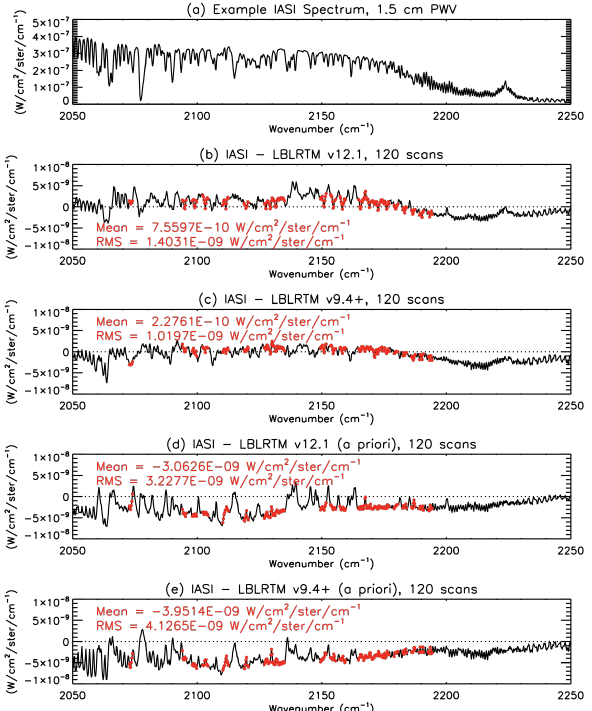
Fig. 27. (a) IASI-observed radiance spectrum in the fundamental vi- brational band of CO for an example profile with 1.5cm PWV. (b) Mean of the final (a posteriori) radiance residuals for 120 spectra us- ing LBLRTM v12.1. (c) Mean of the final radiance residuals for 120 spectra using LBLRTM v9.4 + . (d) Mean of the a priori radiance residuals for 120 spectra using LBLRTM v12.1. (e) Mean of the a priori radiance residuals for 120 spectra using LBLRTM v9.4 + . The CO retrieval windows are highlighted in red. Note that the RMS due to instrument noise alone in these windows is 1 . 8 × 10 − 10 Wcm − 2 ster − 1 cm.